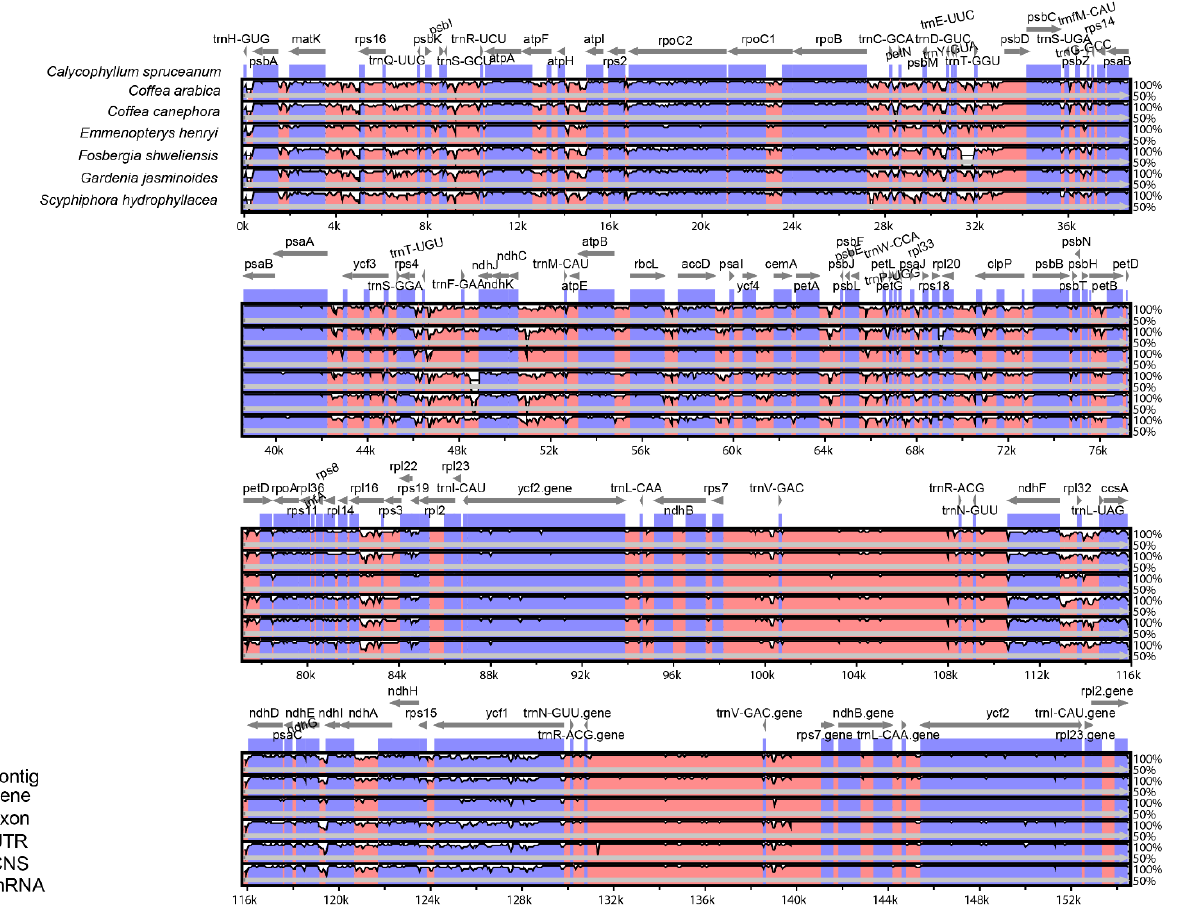
Figure 2. mVISTA identity plot comparing the seven Ixoroideae plastid genomes considering C. spruceanum as a reference. The top line shows genes in order (transcriptional direction indi- cated by arrows). The y -axis represents the percent identity within 50–100%. The x -axis represents the coordinate in the chloroplast genome. Genome regions are color-coded as protein-coding (exon), tR- NAs, or rRNAs, and conserved noncoding sequences (intergenic region). The white block represents regions with sequence variation between two